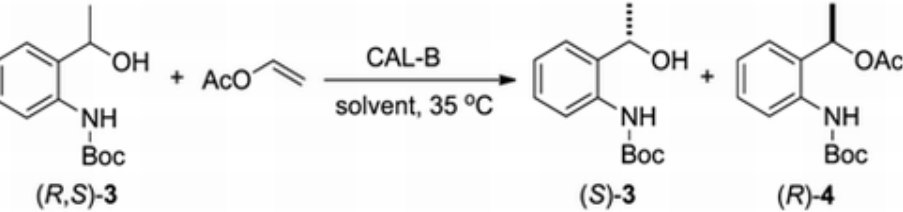
Table 3. Influence of solvent in the lipase-catalyzed transesterfication of ( R,S )- 3